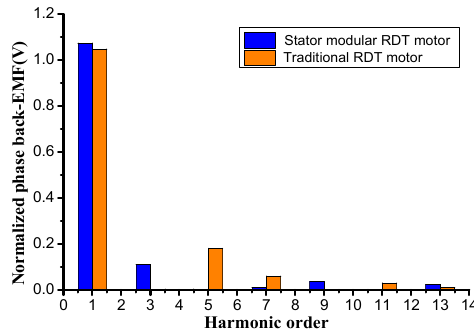
Figure 9. Harmonic analysis of the phase back–EMF.